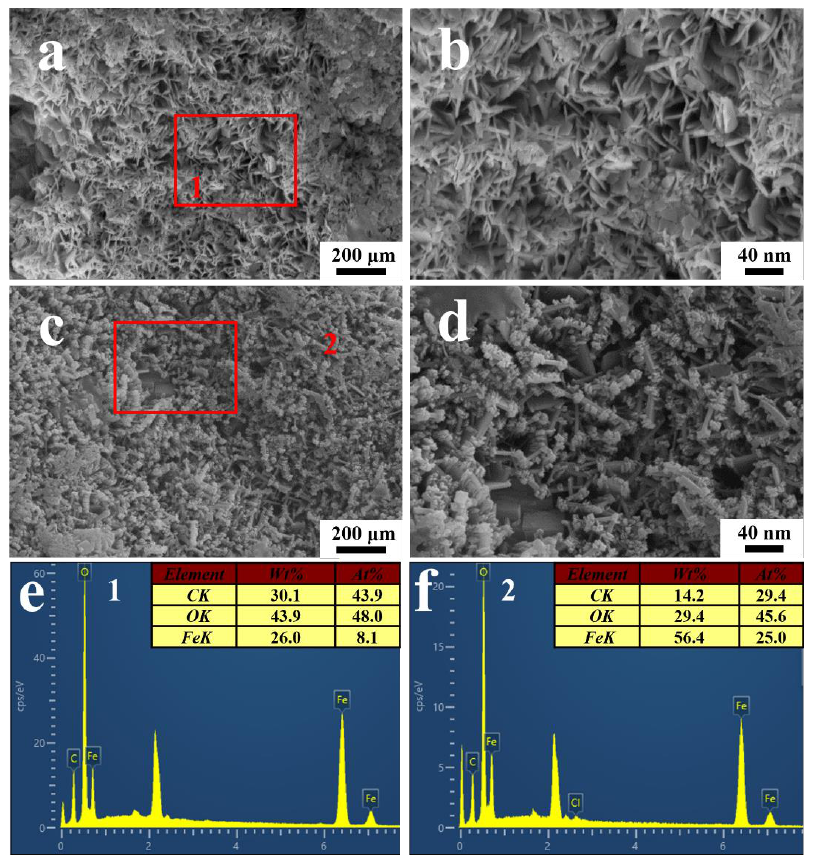
Figure 12. The SEM images of corrosion products underneath the PU coatings after the immersion